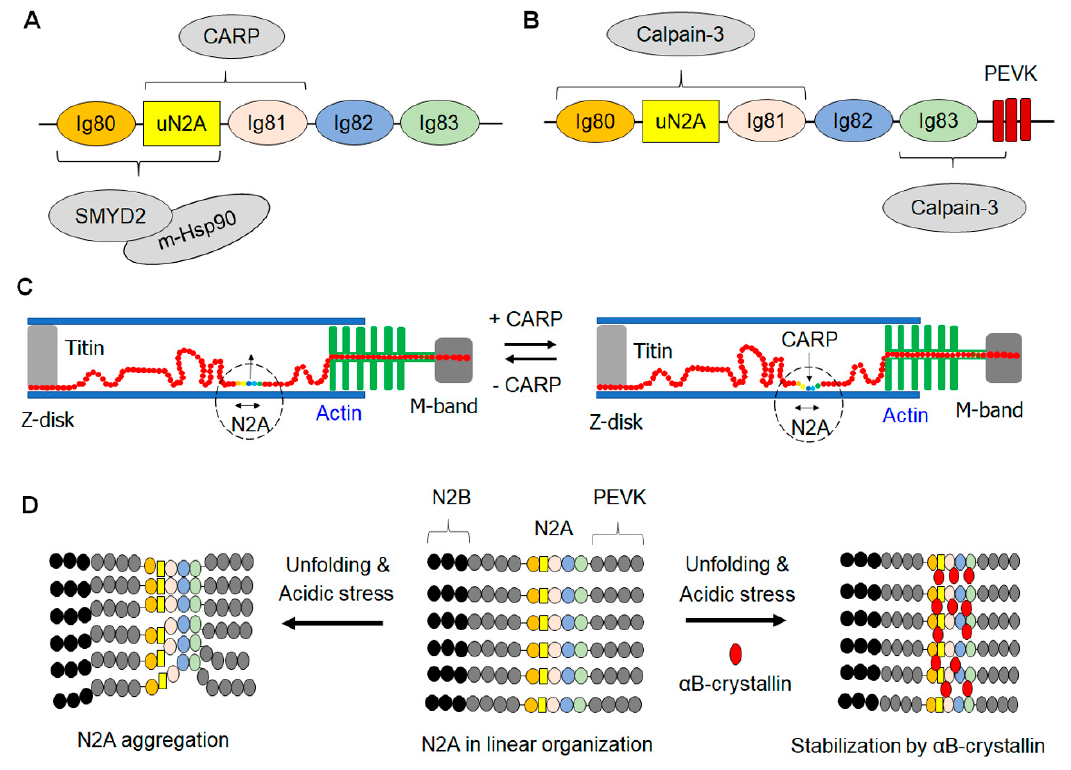
Figure 3. N2A’s interacting partners and potential roles of N2A–protein interactions. ( A ) N2A’s interactions with SMYD2, methyl-Hsp90, and CARP. SMYD2–methyl-Hsp90 and CARP play chaperone roles in protecting or stabilizing their interacting N2A sub-domains against protease activity or unfolding events. ( B ) N2A’s interactions with calpain-3. Calpain-3 binds at least two regions that encompass the N2A sub-domains. N2A’s interaction with calpain-3 makes the calpain-3 inactive, thus regulating the calpain-3 protease activity. ( C ) N2A–F-actin complex formation in the presence of CARP. CARP locks titin’s N2A domain to the actin filament, thus increasing titin’s passive force or stiffness during skeletal myofibril stretch. ( D ) N2A’s interactions with α B-crystallin. N2A is prone to aggregation in an acidic environment upon unfolding that exposes its buried hydrophobic cores. α B-crystallin binds and stabilizes the N2A region to prevent its aggregation. ( D ) was adapted and redrawn from Kotter et al.’s publication